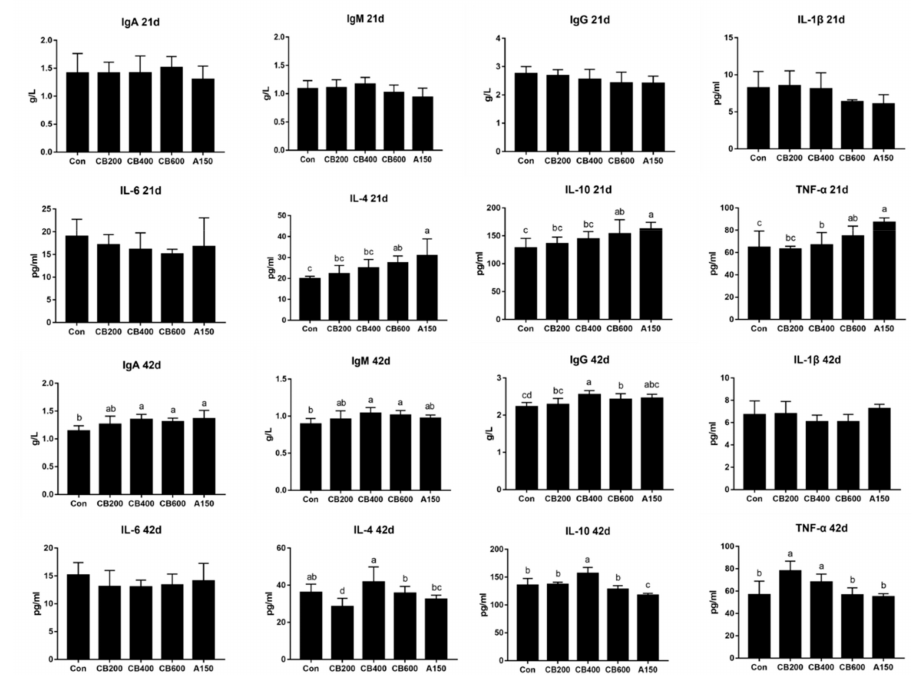
Figure 1. Effects of C. butyricum and aureomycin on serum immune parameters of Pekin ducks at 21 d and 42 d, respectively (N = 10 replicates per group). The data were presented as mean ± SD, the superscript different letters indicate that there are significant differences ( p < 0.05) between any two groups. Con, group Con; CB200, group CB200; CB400, group CB400; CB600, group CB600; A150, group A150.